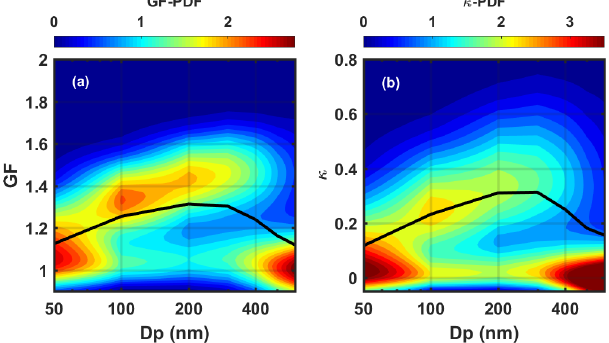
Figure 2. Averaged probability distribution functions of (a) growth factor and (b) hygroscopicity parameter κ . The black lines in these two figures represent the ensemble mean